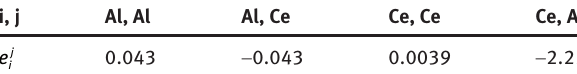
Table 2: The interaction coefficient j i e of the various elements in liquid steel in 1600–1700°C